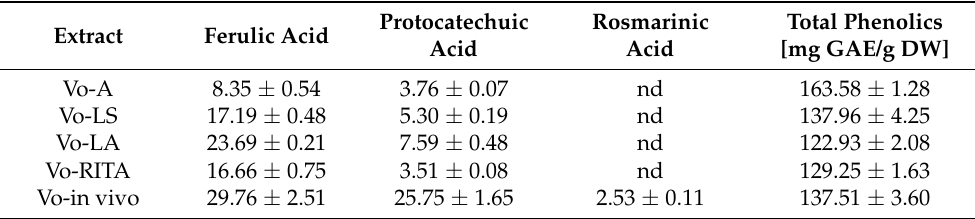
Table 3. Phenolic acid concentrations (mg/100 g DW ± SD) and total phenolic content measured in extracts of V. officinalis in vitro cultures; agar (Vo-A), stationary liquid (Vo-LS), agitated (Vo-LA) and bioreactor cultures (Vo-RITA) and from plant material (Vo-in vivo). Protocatechuic Extract Ferulic Acid